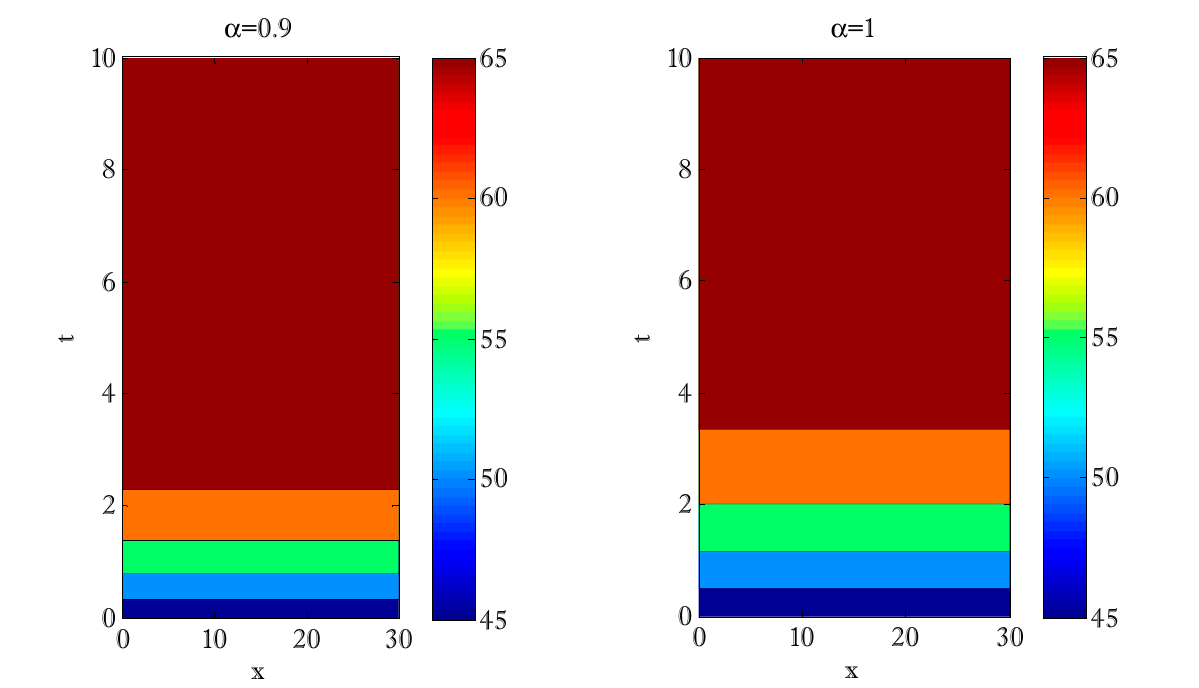
Figure 12. Impact of fractional order parameter α on recovered individuals using N x = 50, N t = 300, α 1 = 0.9, β = 0.9, γ = 0.7, σ = 0.9, µ = 0.9, d 1 = 2, d 2 = 2.5, d 3 = 2.5, d 4 = 2, d 5 = 2, α = 0.9.